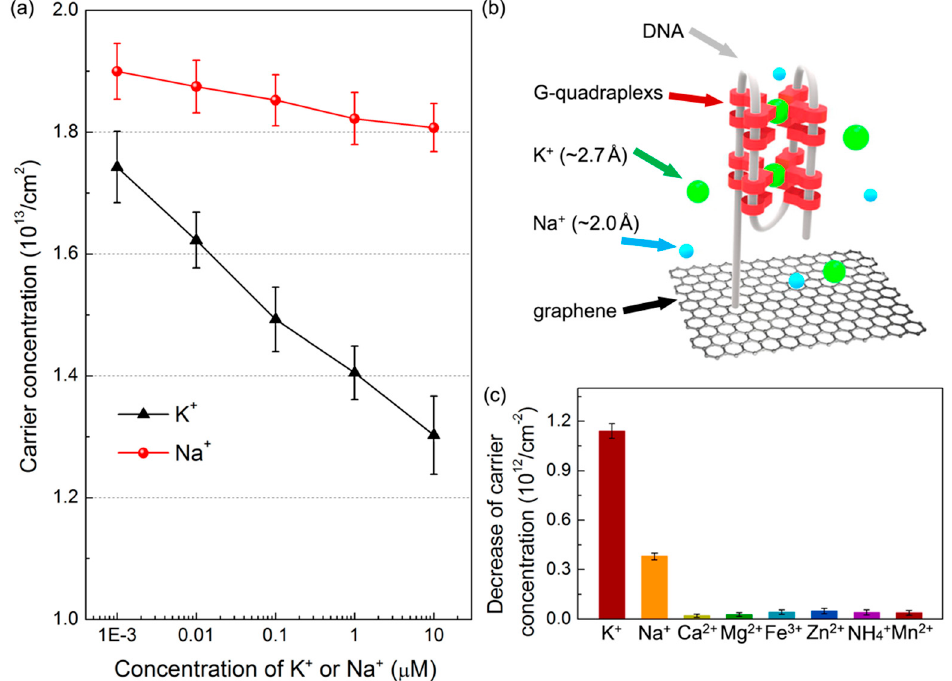
Figure 4. ( a ) Sensitivity and specificity comparison between K + and Na + ions; ( b ) Schematic illustration of the interaction between K + ions and guanine-quadruplexes; ( c ) High selectivity for K + ion detection over other interfering cations (added concentrations: K + 1 nM; Others 10 nM).